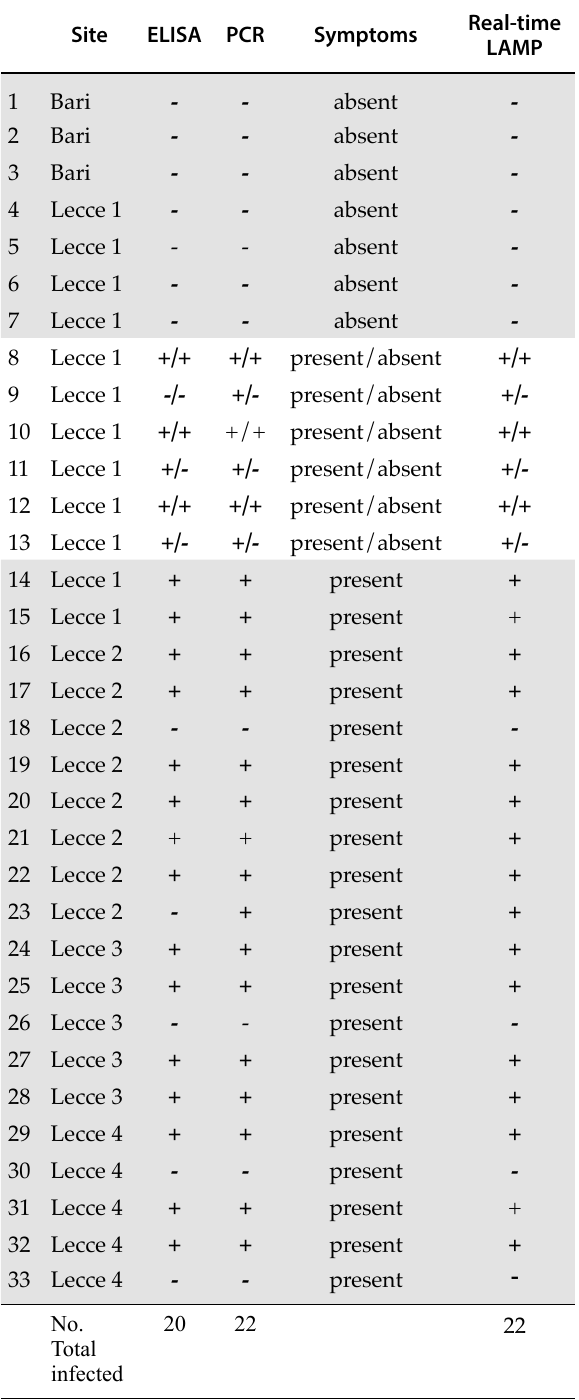
Table 1. Detection of X. fastidiosa from symptomatic and ‘healthy’ olive plants, using real-time LAMP, PCR and